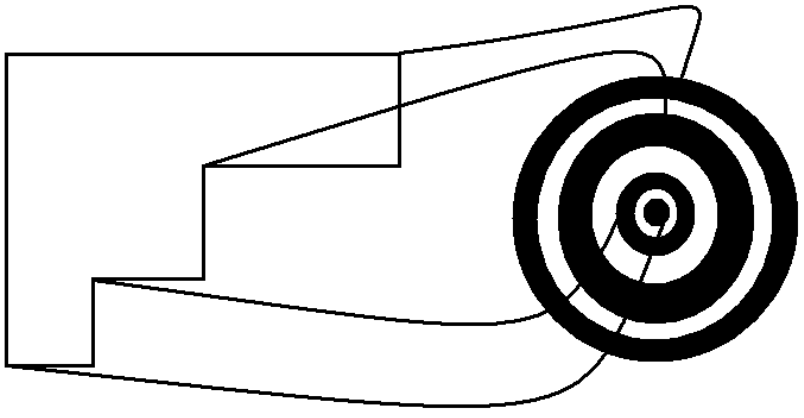
Figure 1 . An example of the map between Young diagrams and LLM boundary